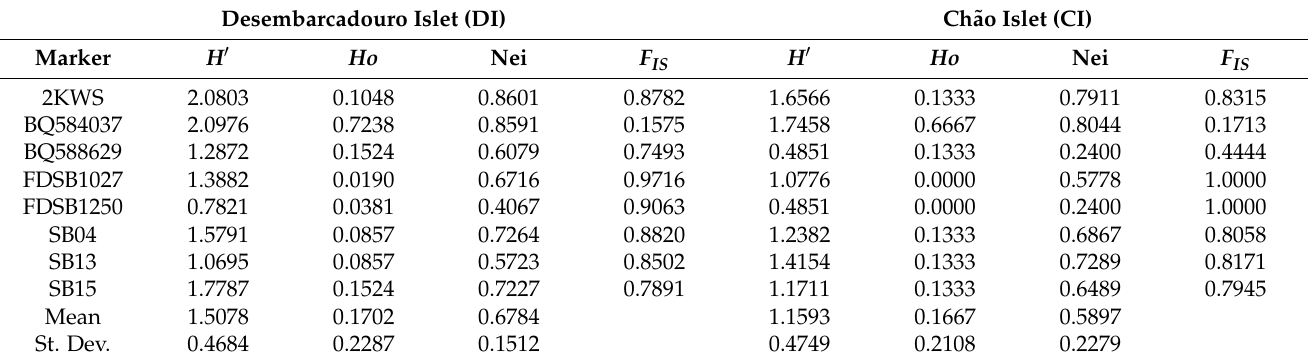
Table 3. Obtained values for Shannon–Wiener’s index ( H (cid:48) ), observed heterozygosity ( Ho ), Nei’s